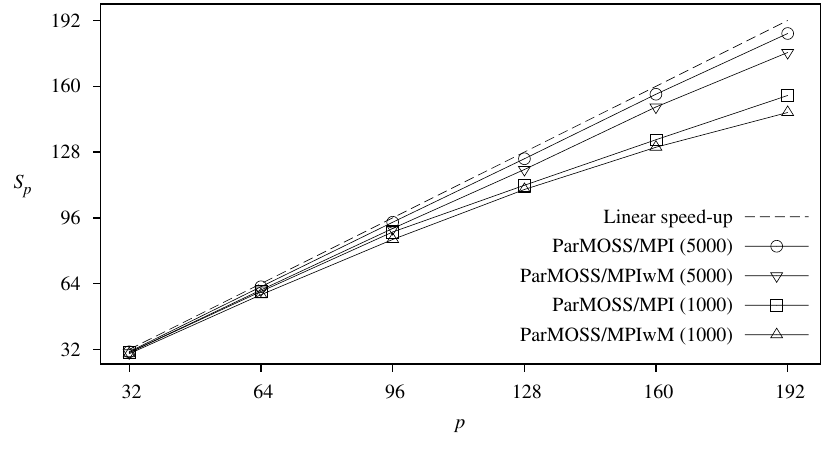
Figure 11. Speed-up of ParMOSS/MPI using different number of processing units and different number of demand points.